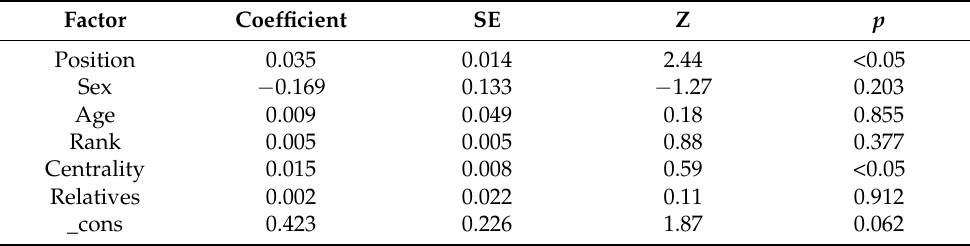
Table 4. Results of the Tobit regression modelling testing the factors affecting the pause